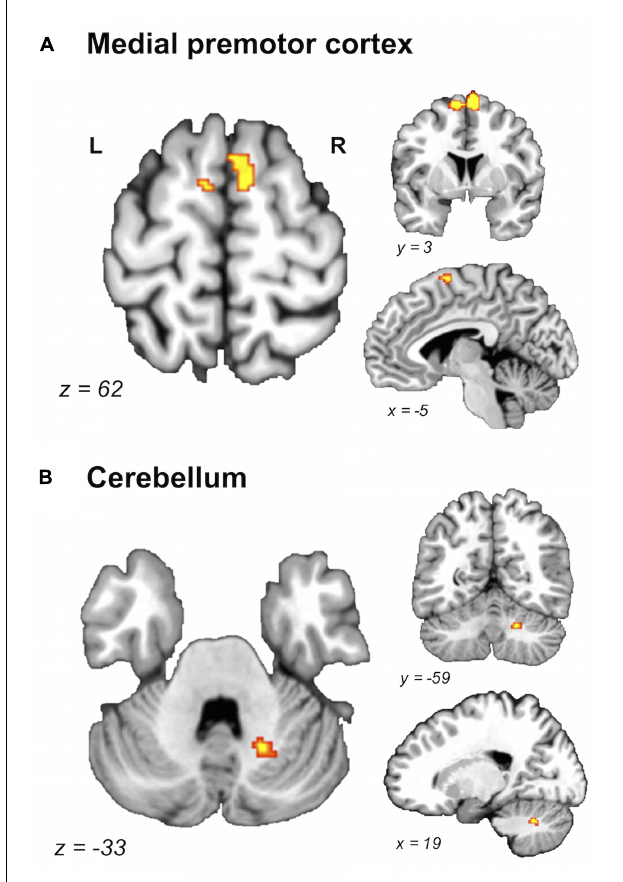
FIGURE 3 | Brain areas showing greater likelihood of activation in young compared with older adults. Whole-brain ALE maps for the young > older adult contrast (voxel-wise FDR correction at p < 0.05, k > 100 mm 3 ). Suprathreshold ALE values were observed in antero-dorsal regions of medial premotor cortex (A) and right cerebellum (B) . L, left hemisphere; R, right hemisphere. Table 5 provides the full list of ALE peaks for this